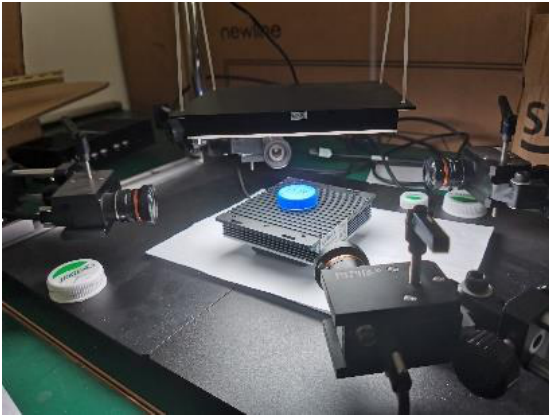
Figure 10. The unfolding and stitching flowchart of the cap: ( a ) The 3d model of the cap; ( b ) The best observation regions of the camera; ( c ) The cylindrical back-projection on the best observation regions of the camera; ( d ) The stitched result of the ( c ).